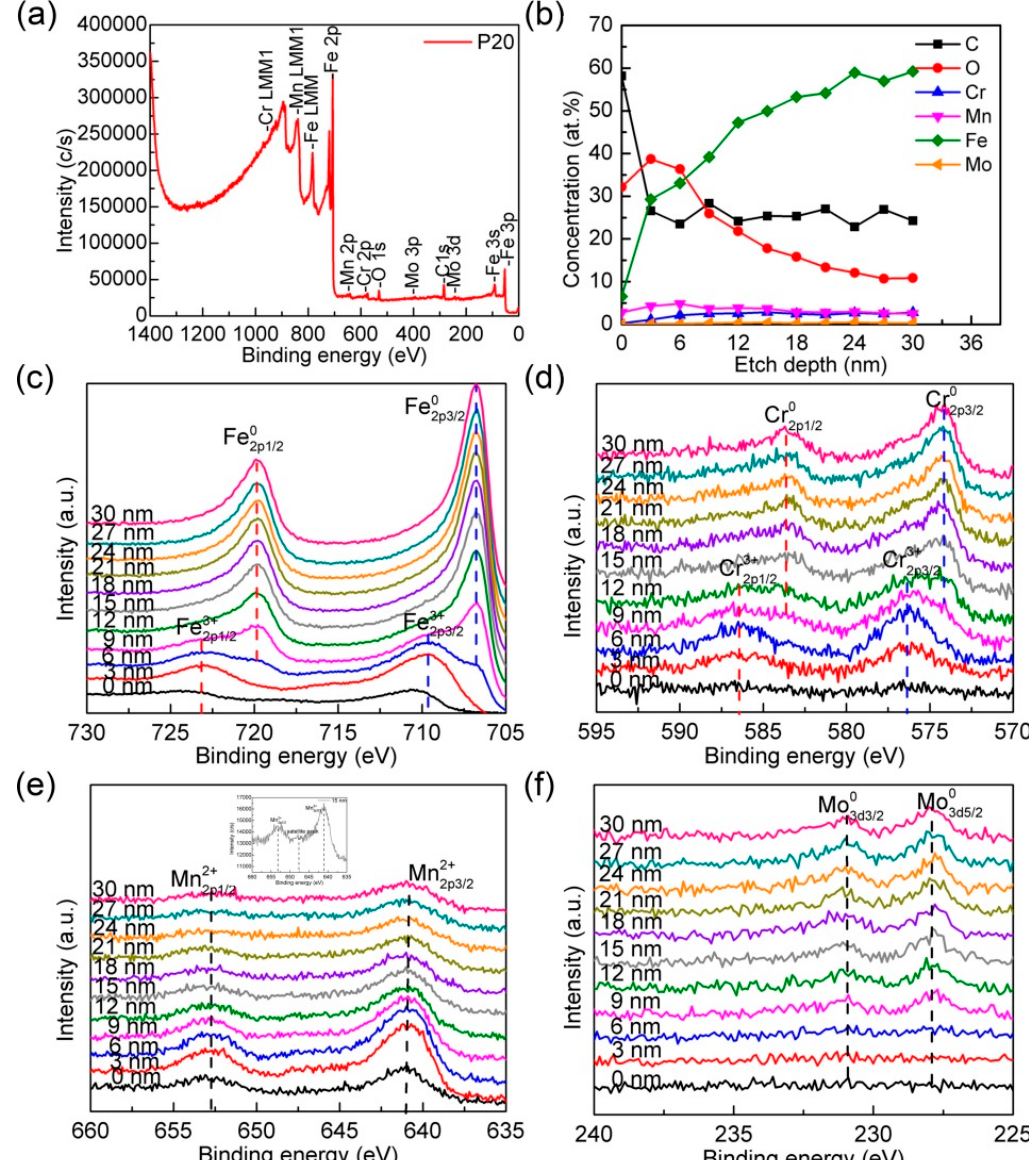
Figure A2. ( a ) XPS survey spectrum and ( b ) depth profile analyses of element concentrations, and detailed XPS spectra of ( c ) Fe, ( d ) Cr, ( e ) Mn and ( f ) Mo on the surface of P20 powders in the as-received state and after ion etching up to 30